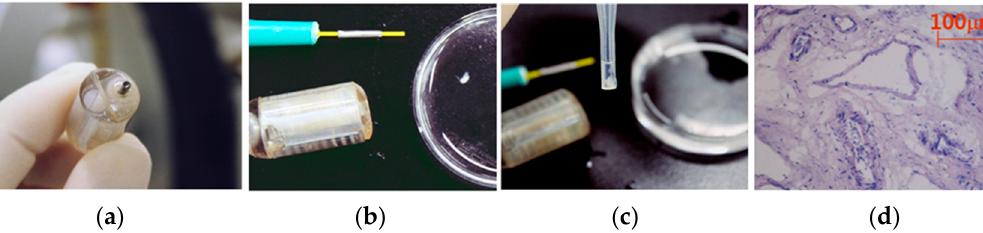
Figure 10. Biopsy sample examination processes. ( a ) ACE with the biopsy tool after the ex-vivo experiment. ( b ) Removal of the biopsy punch from the capsule. ( c ) Collected tissue fixation before analysis. ( d ) Biopsy tissue under a microscope.